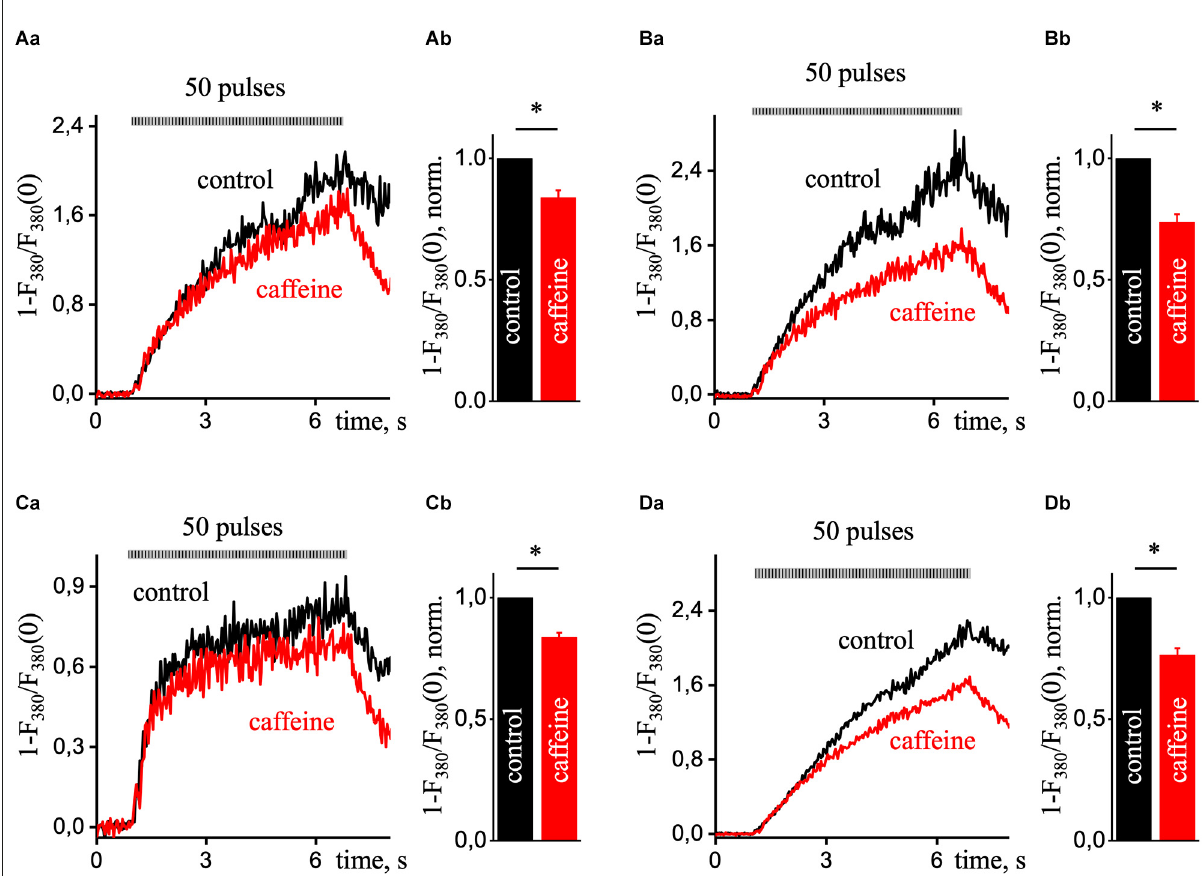
FIGURE5 Ca 2 + transients during prolonged electrical field stimulation in the presence of caffeine in various ROIs of hippocampal pyramidal neurons. A transient increase in intracellular [Ca 2 + ] i is induced by a series of 50 EFS pulses (9 Hz) under control conditions (black line) and in the presence of 10 mM caffeine (red line; which excludes calcium release from the ER). Each graph in part (a) presented Ca 2 + responses that were recorded in the sub-membrane (A) , central (B) , dendritic tree (C) , and nucleus (D) of the cell. Normalized Ca 2 + transients were recorded using a single wavelength protocol (33 ms per image and 380 nm excitation wavelength). Part (b) of each panel presents control-normalized statistics of maximal amplitude in the presence of caffeine in response to ESP. Results are mean ± S.E. ∗ P <